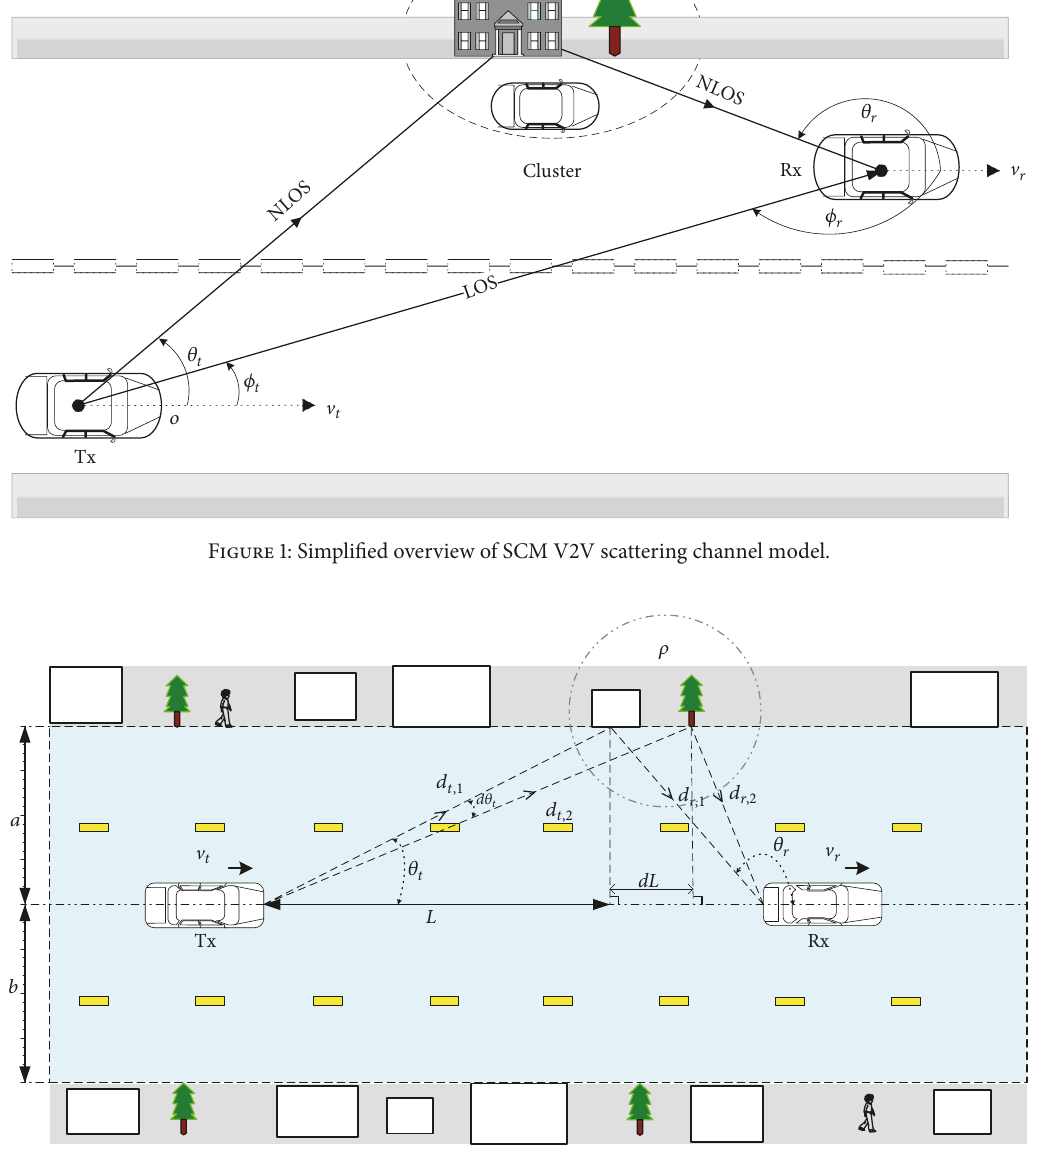
Figure 2: Geometrical model for V2V channel in roadside scattering